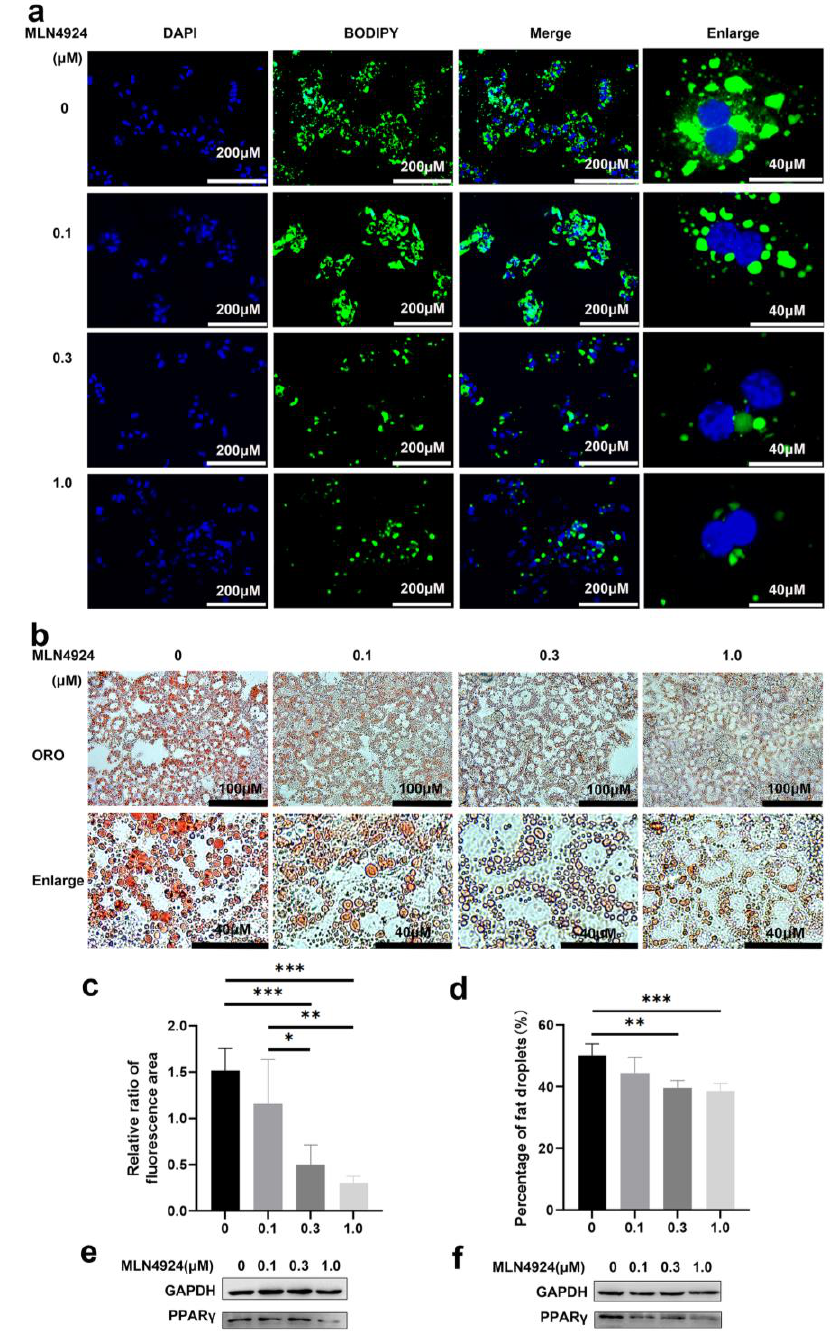
Figure 2. Neddylation inhibitor MLN4924 can inhibit lipid droplets induction by free fatty acid in hepatocytes. Primary hepatocytes were treated with 0, 0.1, 0.3 or 1 μM MLN4924 and 1 mM FFA for 8 h. Representative images of DAPI, BODIPY staining ( a ) and oil red O staining (ORO) ( b ) were presented. Scale bar: 40 μM and 200 μM for DAPI, BODIPY image, 40 μM and 100 μM for oil red O staining image. ( c ) Relative ratio of fluorescence area of DAPI and BODIPY staining were quantified. ( d ) Statistical analysis of area of fat droplets stained with oil red O (ORO) were presented. Huh7 cells ( e ) and primary hepatocytes ( f ) were treated with 0, 0.1, 0.3 or 1 μM MLN4924 and 1 mM FFA for 16 h. Representative images of western blot showed the effects of FFA on PPARγ expression. GAPDH was used as an invariant control. Data represents the mean ± SD, n ≥ 3. One-way ANOVA was used for statistical analysis (* p < 0.05, ** p < 0.01, *** p < 0.001).